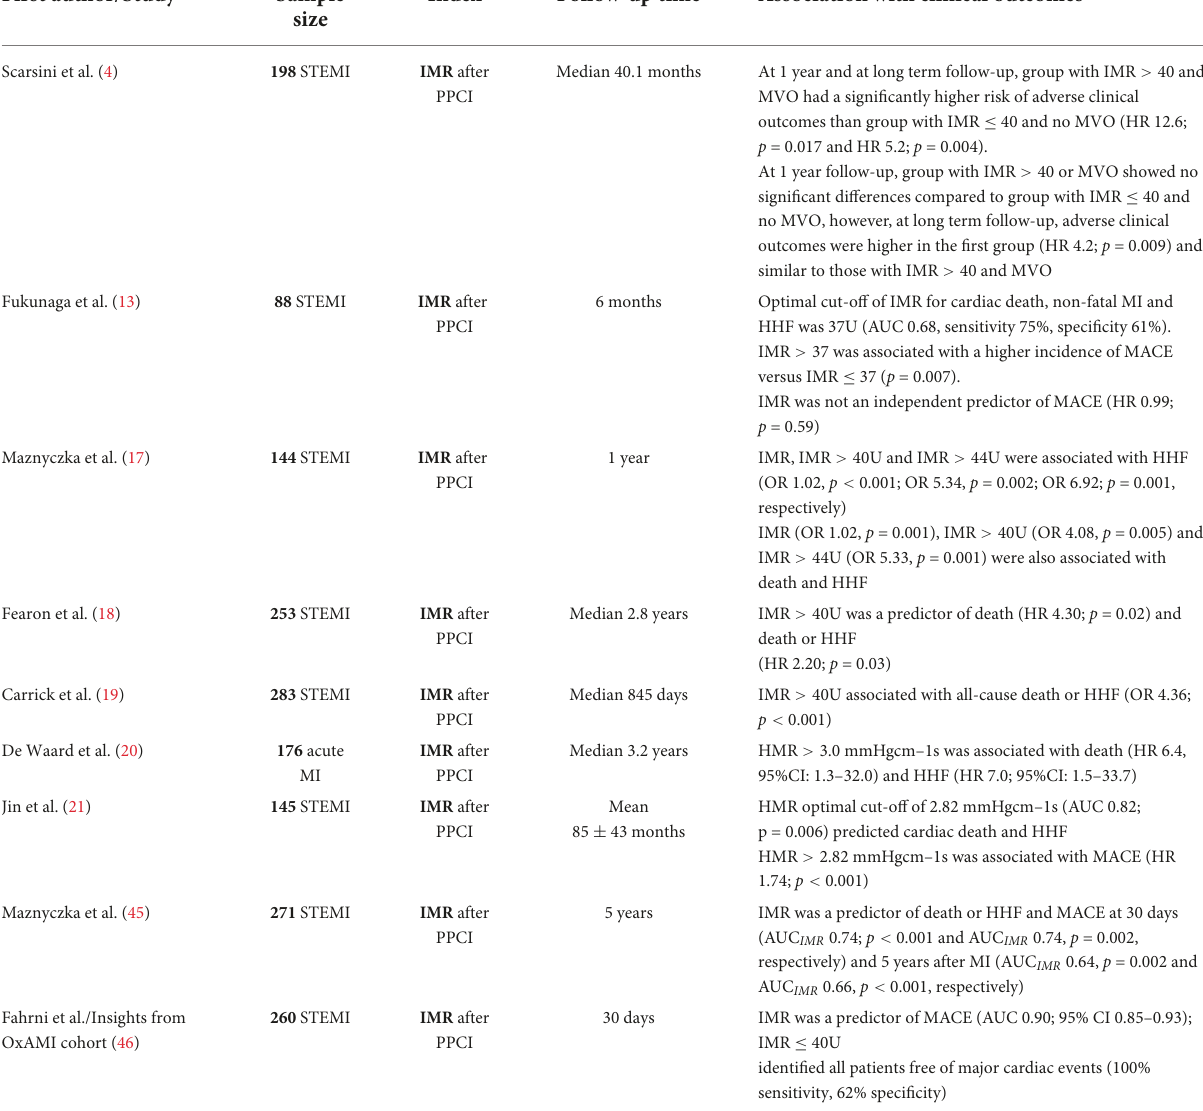
TABLE 2 Non-randomized controlled trials of microvascular resistance indices in acute MI associated with clinical